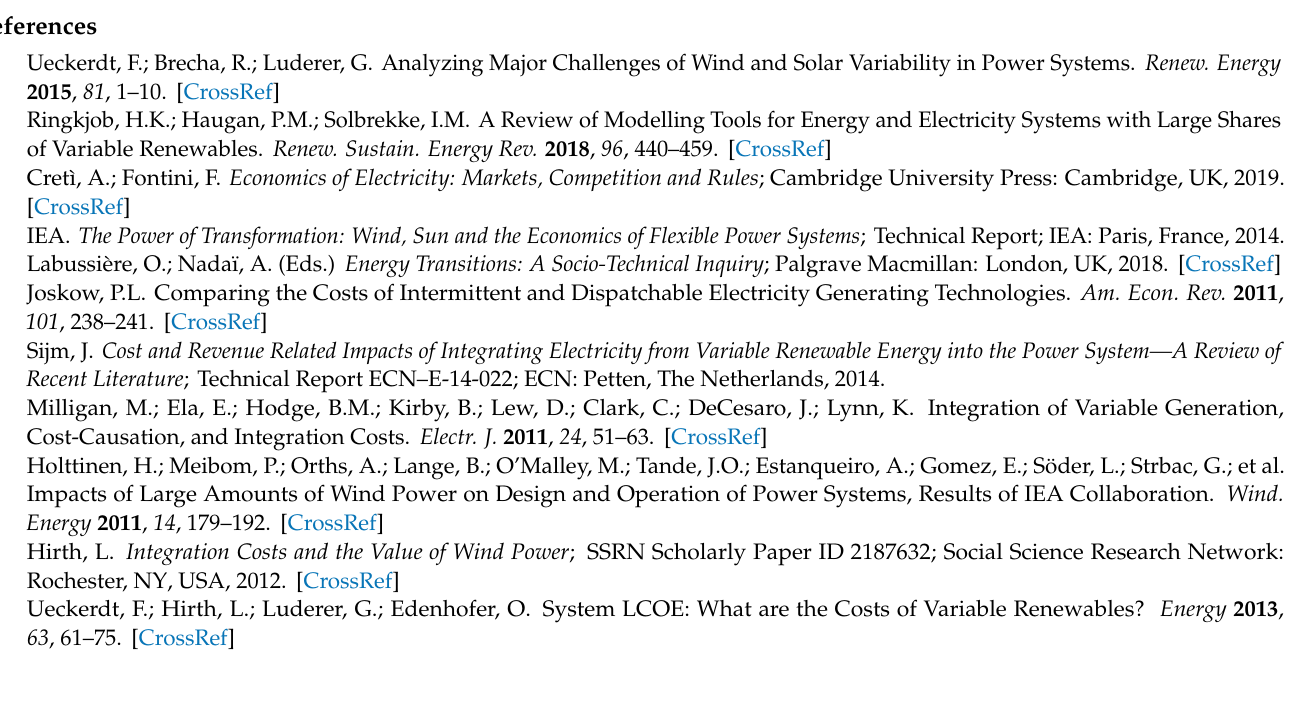
Figure A1. Average penetration ( top left ), fraction of energy curtailed ( top right ), expected system total cost ( bottom left ), and average system marginal cost ( bottom right ) for optimal solutions to the variable problem versus the expected system total cost without variable renewable energy using time series starting in 2019, 2015, 2010, 2005, or 2000 and finishing in